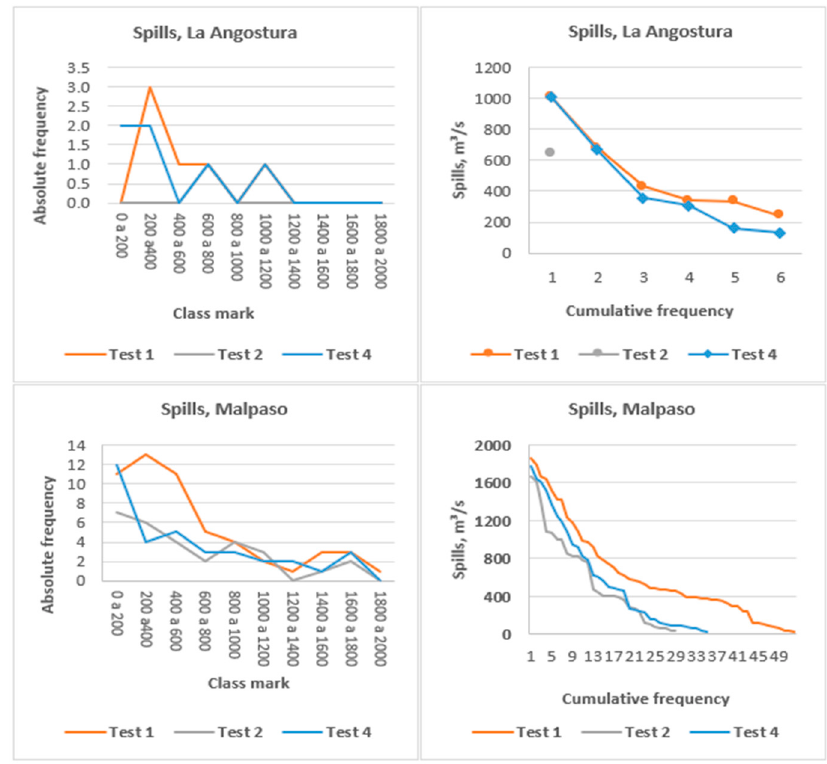
Figure 12. Spill count with the combined guide curve policy.